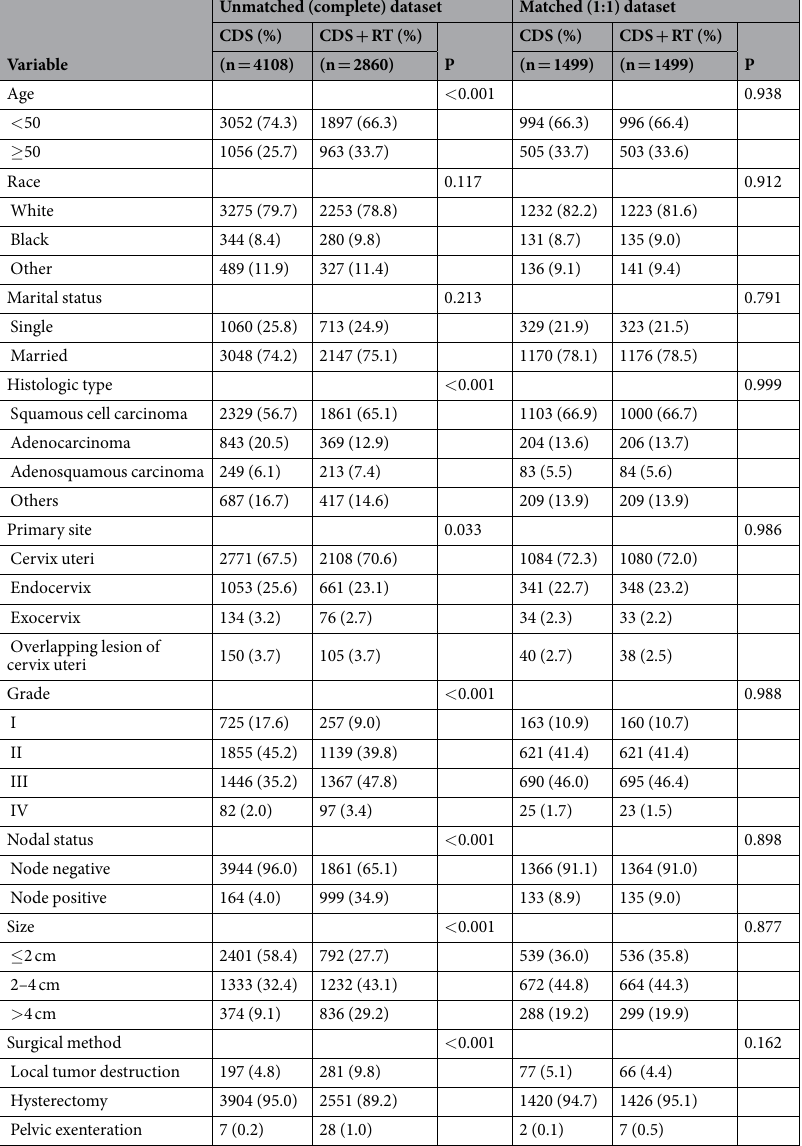
Table 3. Baseline characteristics of PSM cohorts for FIGO stage IB-IIA. CDS: cancer-directed surgery; RT: